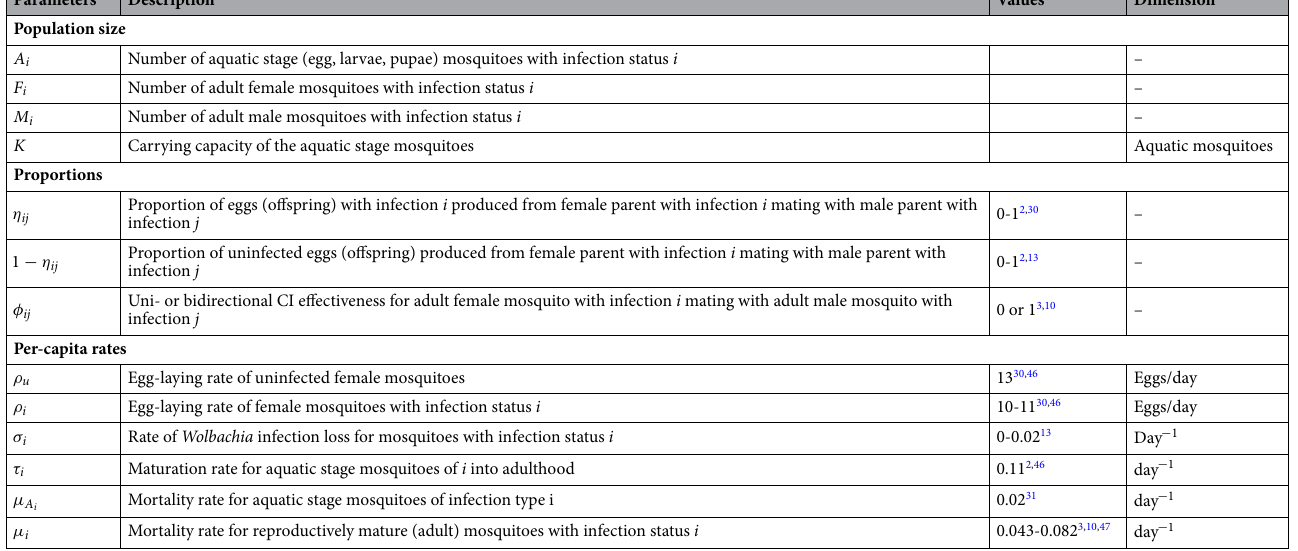
Table 1. Mosquito- Wolbachia Model Parameters.